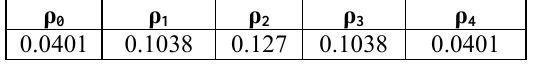
Table 2: Calculated coefficients of Chebyshev transformer.